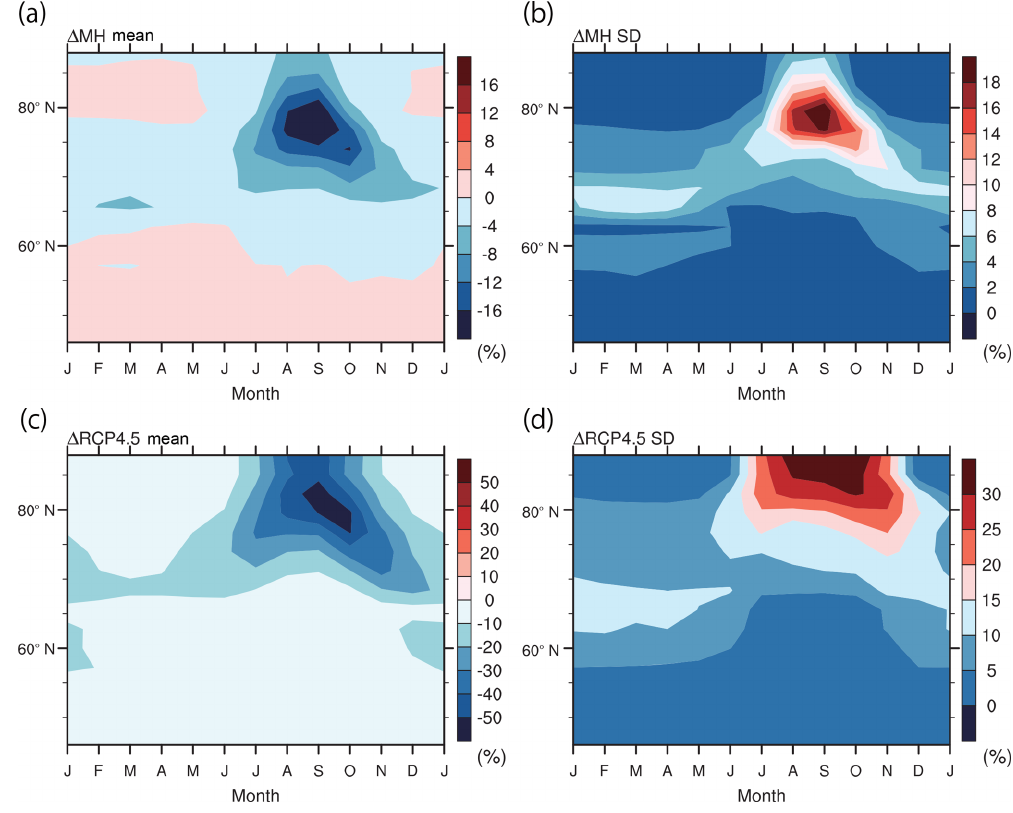
Figure 11. Same as in Fig. 6 but for the sea ice concentration (%) (north of 60 ◦ N). All 10 models listed in Table 2 are